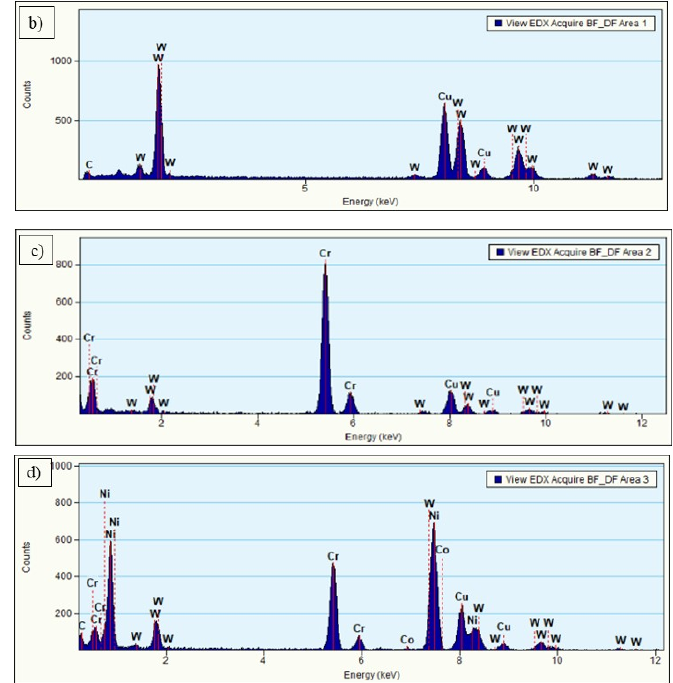
Figure 11. The SAED electron diffraction of sample C2, performed for the area marked as B ( a ) and amorphous matrix ( b ).